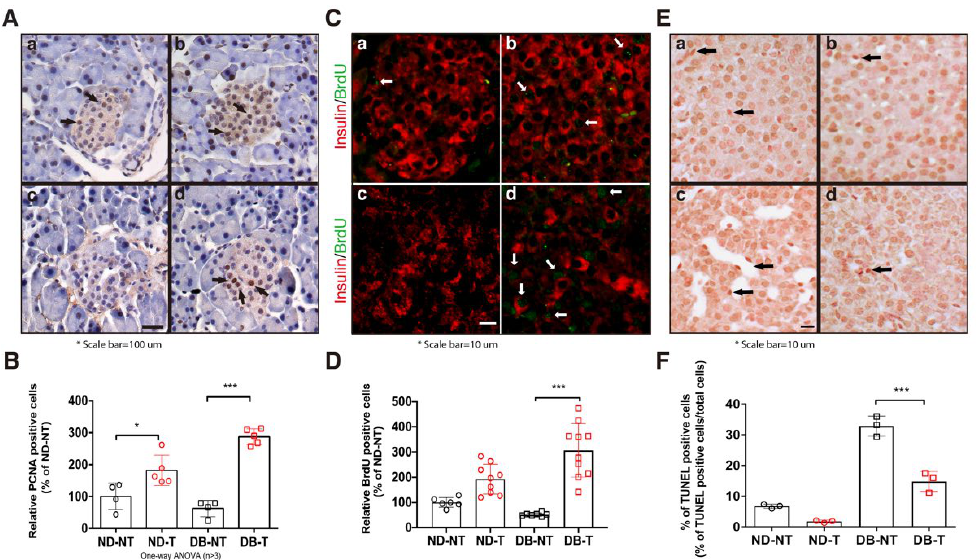
Figure 2. Effect of hydrolyzed SF on pancreatic β -cell proliferation and death in the pancreatic tissue. ( A ) Immunohistochemistry of pancreatic islets with antibody against the proliferating cell nuclear antigen (PCNA). Arrows point to representative PCNA-positive nuclei. ( a : ND-NT, b: ND-T, c : DB-NT, and d : DB-T) ( B ) Quantification of PCNA-positive pancreatic β -cells ( n > 4). Data are presented as mean ± SEM. One-way ANOVA, * p < 0.05, *** p < 0.001. ( C ) BrdU staining of pancreatic islets with the anti-BrdU antibody. White arrows indicated representative BrdU-positive signals. ( a : ND-NT, b : ND-T, c : DB-NT, and d : DB-T) ( D ) Quantification of BrdU-positive pancreatic β -cells ( n > 6). Data are presented as mean ± SEM. One-way ANOVA, *** p < 0.001. ( E ) TUNEL assay using the pancreatic islets from each experimental group. Arrows point to representative TUNEL-positive nucleus. ( F ) Quantification of percent of TUNEL-positive pancreatic β -cells (% of TUNEL positive cells / Total cells) ( n > 3). Data are presented as mean ± SEM. One-way ANOVA, *** p < 0.001.